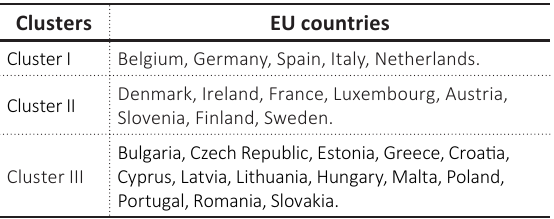
Table 2. Clusters of the EU member countries according to the circular economy development indicators